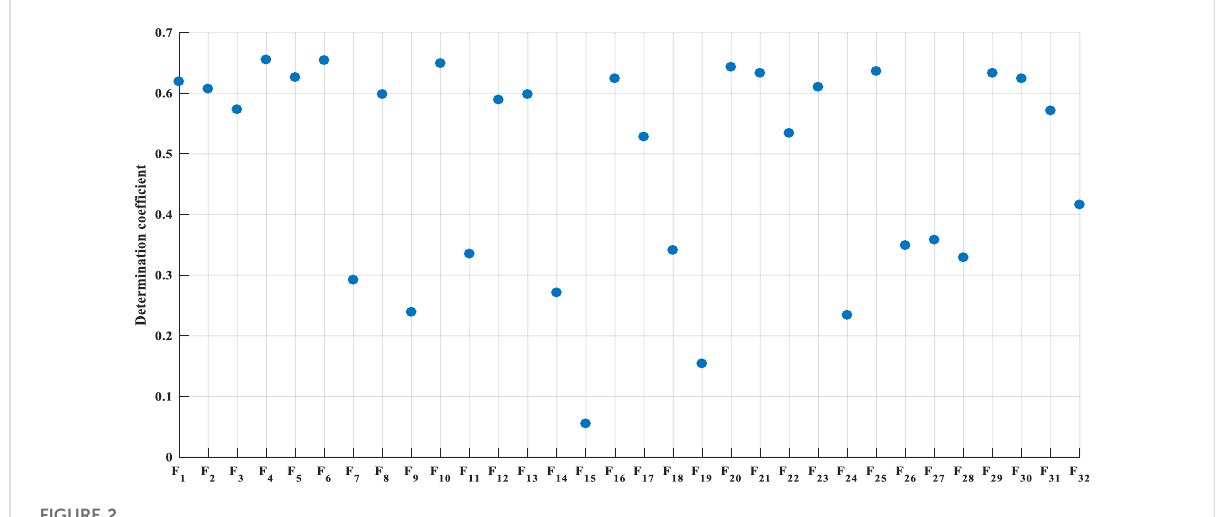
FIGURE 2 The determination coef fi cient of 32 indicators for Technology and